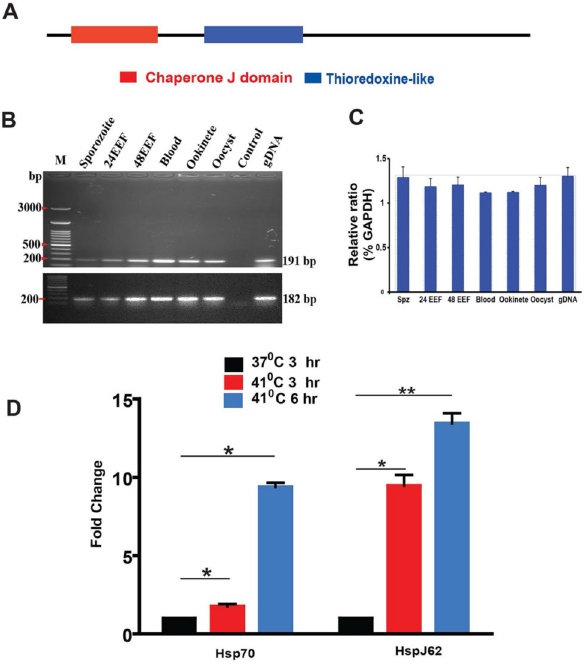
Figure 1. HspJ62 is induced under heat stress conditions. ( A ) In silico analysis of the functional domains of HspJ62 shows that the DnaJ domain (34–93 amino acids) and thioredoxine-like domain (188–289 amino acids) are typical of the Type II HSP40 protein family. ( B ) The result of PCR using cDNA synthesized from RNA isolated from different stages of parasite is shown. PCR analysis shows the presence of gene transcripts throughout the life cycle of parasites. Genomic DNA (gDNA) was used as a positive control, while water was used in place of a template in the negative control; EEF: exoerythrocytic forms 24 and 48 h post infection; Blood: mixed blood stages. Full blots are shown in Supplementary Fig. 5A and B. ( C ) Bands present in figure A were quantified by densitometry and normalized to Gapdh and plotted as graph. ( D ) Quantitative PCR using RNA extracted from blood stage parasites cultured at normal 37 °C and higher 41 °C temperatures. The transcript levels were normalized to the Gapdh housekeeping gene, and Pb Hsp70-1 transcript was included as a positive control. The data are shown as the gene expression at 41 °C compared to 37 °C and represent the mean value of two separate experiments performed in triplicate along with standard error of the mean (SEM) shown as error bars. Statistical analysis was performed using the unpaired T-test; **P < 0.01, *P <